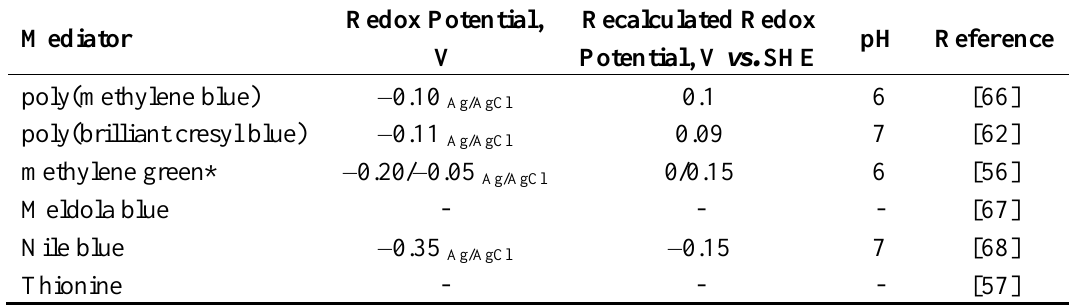
Table 4. Typical mediators for GDH-based glucose